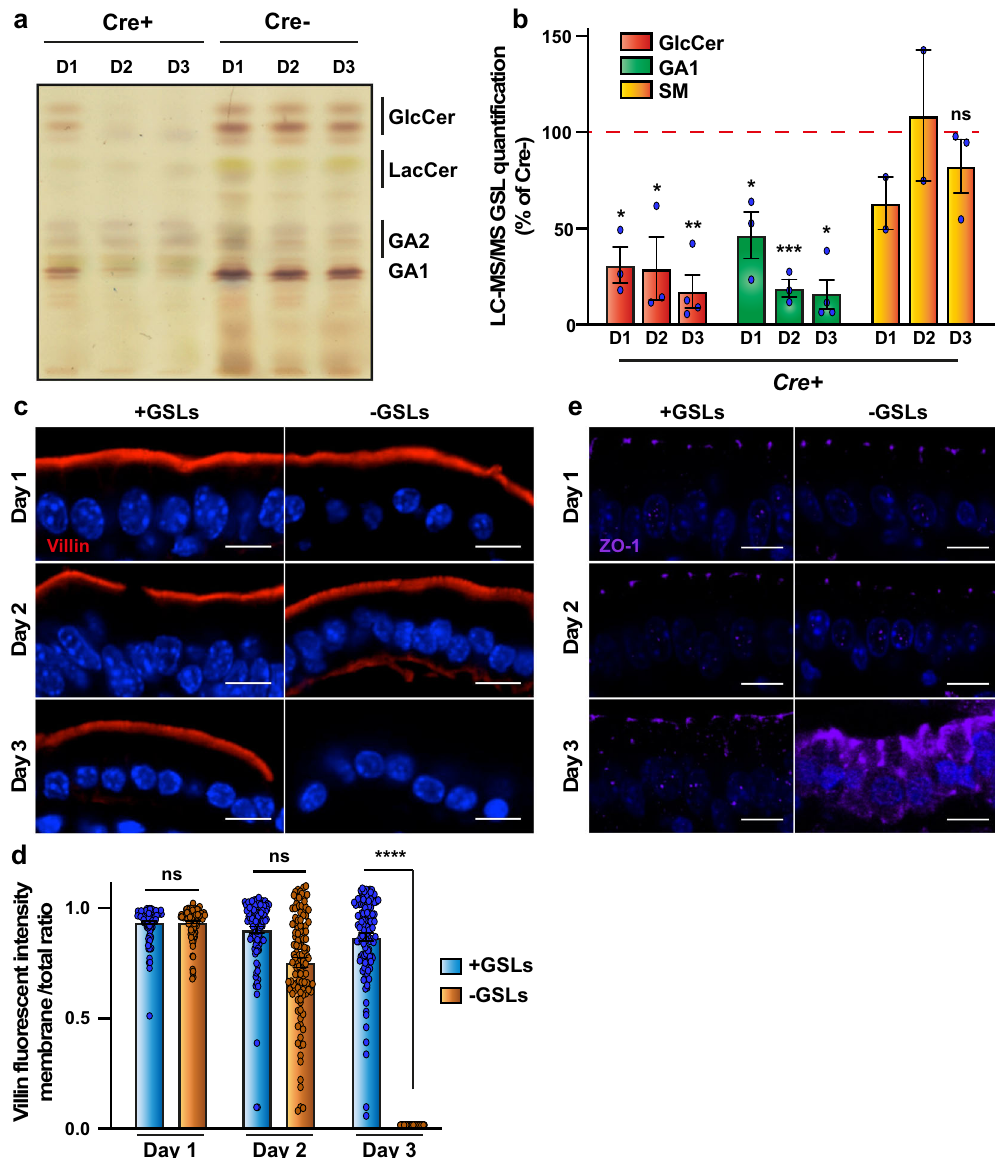
Fig. 4 Tissue integrity under GSL depletion conditions. a Ugcg fl ox/Cre + or Ugcg fl ox/Cre − mice were injected with 1 mg of TAM. At days 1, 2, or 3 post- injection, the jejunum was excised and analyzed for GSL expression using thin-layer chromatography. D1-3(Cre − ) samples contain a GSL-triple-band migrating at the height of the GlcCer standard, and a double band at the height of the GA1 standard (indicated on the right side). Non-purple bands are other lipids than GSLs. All GSL bands are strongly reduced in the D1-3(Cre + ) samples. GA2 = Gg 3 Cer, GA1 = Gg 4 Cer. b Relative quanti fi cation of GSL by LC-MS/MS. Lipid extracts containing internal standards were analyzed by RP18-LC-MS/MS. Total intensities of GSL signals were normalized to the internal standards and to the intensity of the corresponding untreated control samples (% of Cre − ). The GSL-unrelated sphingomyelin did not display any signi fi cant alteration upon Ugcg depletion. Mean percentage ± SEM. GA1/GlcCer quanti fi cation, three independent experiments for D1 and D2, and 4 independent experiments for D3; SM quanti fi cation, two independent experiments for D1 and D2, and three independent experiments for D3. Student ’ s unpaired t test, ∗ P < 0.03, ∗∗ P < 0.002, ∗∗∗ P < 0.0002, ns: non-signi fi cant. c – e Conservation of tissue integrity under GSL depletion conditions. Immunohistochemistry on jejunum of Ugcg fl ox/Cre - ( + GLSs) or Ugcg fl ox/Cre + (-GSLs) mice at the indicated days after TAM injection. Immunolabeling for villin ( c ) or ZO-1 ( e ). Note that at days 1 and 2 after TAM injection, staining patterns are not visibly altered under GSL depletion conditions. Data from ( c ) are quanti fi ed in ( d ) (membrane signal/total signal ratio ± SEM, n = 113 cells quanti fi ed for day 1 Ugcg fl ox/Cre − and day 2 Ugcg fl ox/Cre + , and n = 112 cells quanti fi ed for the other conditions; one representative of three independent experiments). Nuclei in blue. Student ’ s unpaired t test, ∗∗∗∗ P < 0.0001, ns: non-signi fi cant. Scale bars = 10 µ